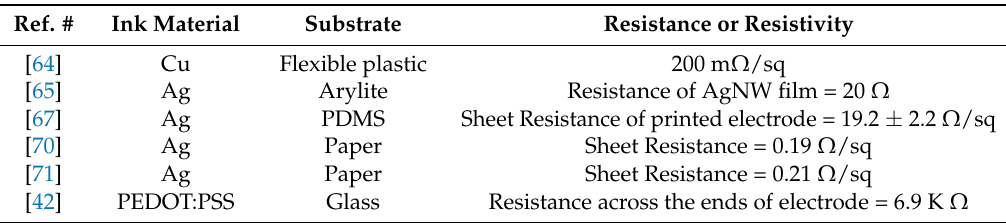
Table 6. Summary of ink materials, substrates and resistance/resistivity of the inkjet-printed capacitive tactile sensors presented in this review